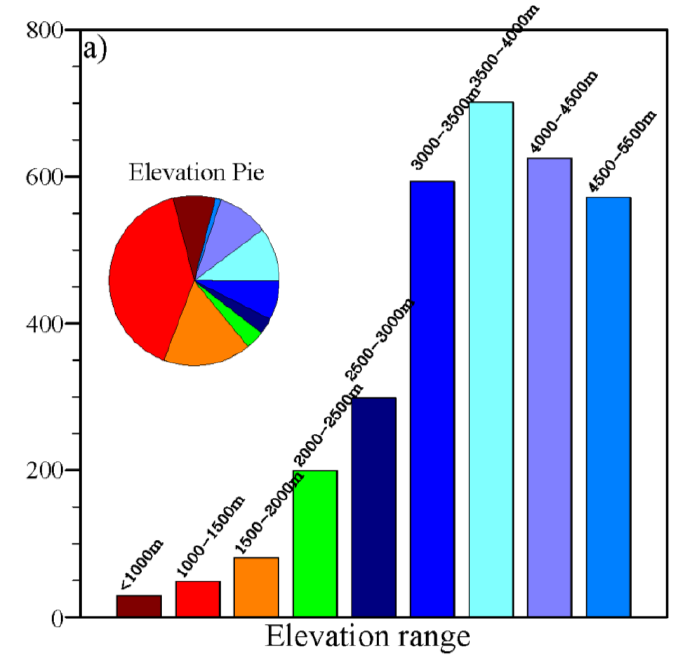
Figure 4. The average annual precipitation at different elevations in the HRB from 2000 to